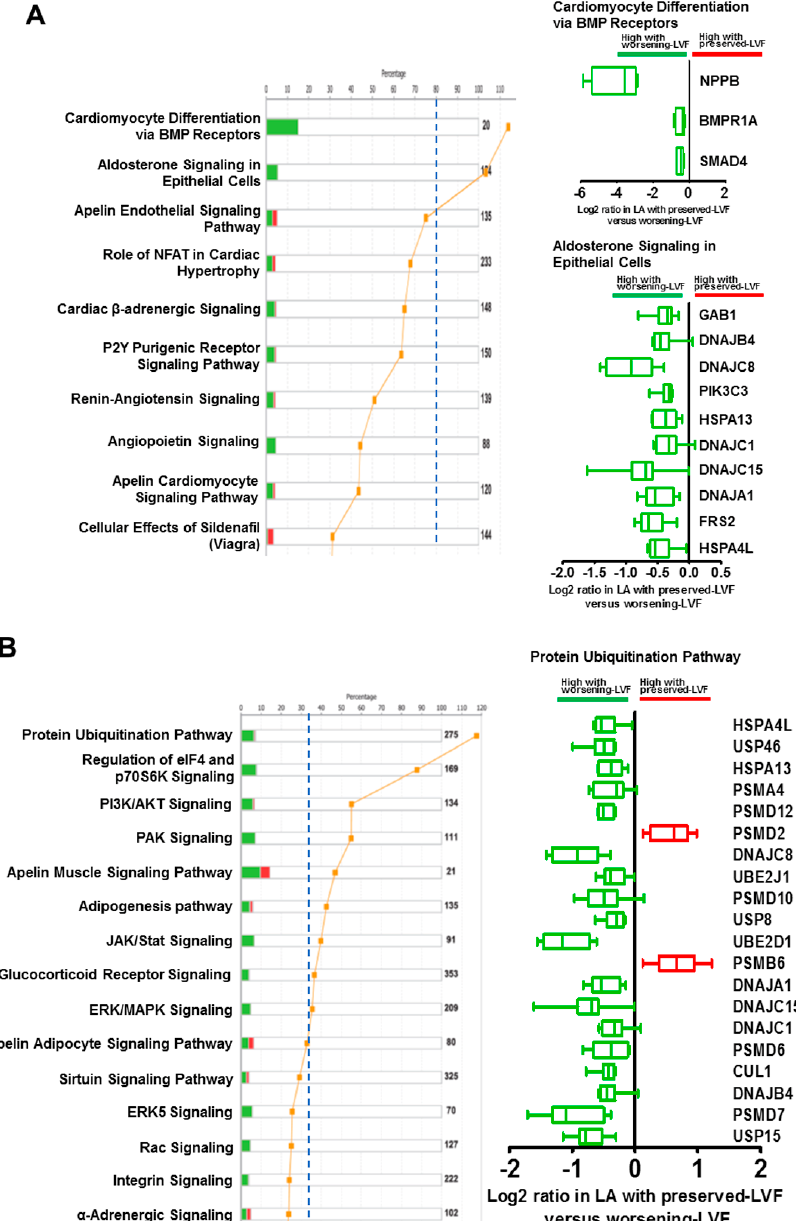
Figure 1. Heatmap and principal component analysis (PCA). ( A ) Unsupervised hierarchical clustering analysis of the gene expression profiles between worsening-LVF and preserved-LVF. Each row represents an individual sample, and each column represents a specific expressed sequence tag (EST). Bar color indicates gene mRNA expression level. The rows (13) of colored bars (718) represent the significant genes altered by more than 25%, between five worsening-LVF patients and eight preserved-LVF patients. The scale bar represents the intensity of expression (green: low expression, black: medium expression, and red: strong expression). The dendrogram on the top depicts the relationship between individuals. The dendrogram scale was calculated via the distance method (i.e., line length is inversely proportional to relatedness). ( B ) The PCA plot demonstrates the quality of the array. Each dot represents an expression profile of an individual sample plotted by the PCA score. • = worsening-LVF; 〇 = preserved-LVF.